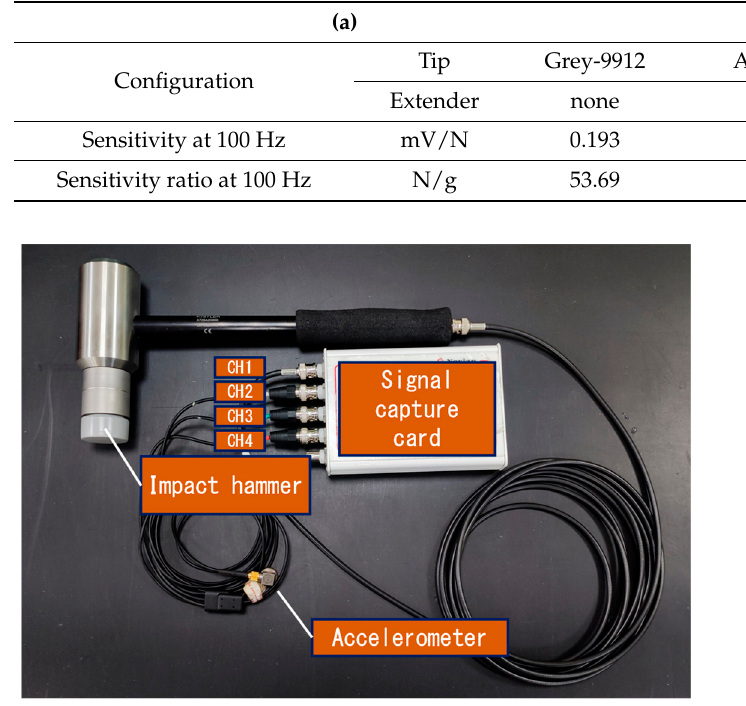
Figure 17. Experimental apparatus.